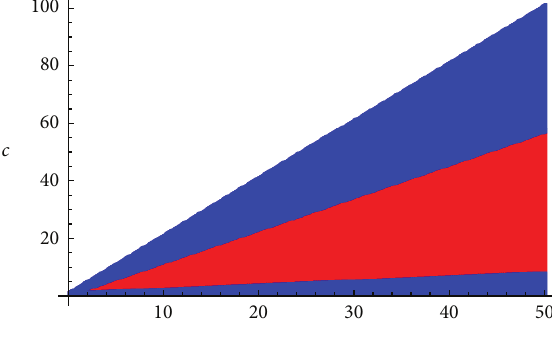
Figure 1: Sign of the first Lyapunov coefficient at 𝑏 = 𝑏 𝑐𝑟 (blue for negative and red for positive values) in the parameter plane (𝜎,𝑐) for system (59) ( 𝑏 2 = −1 ).